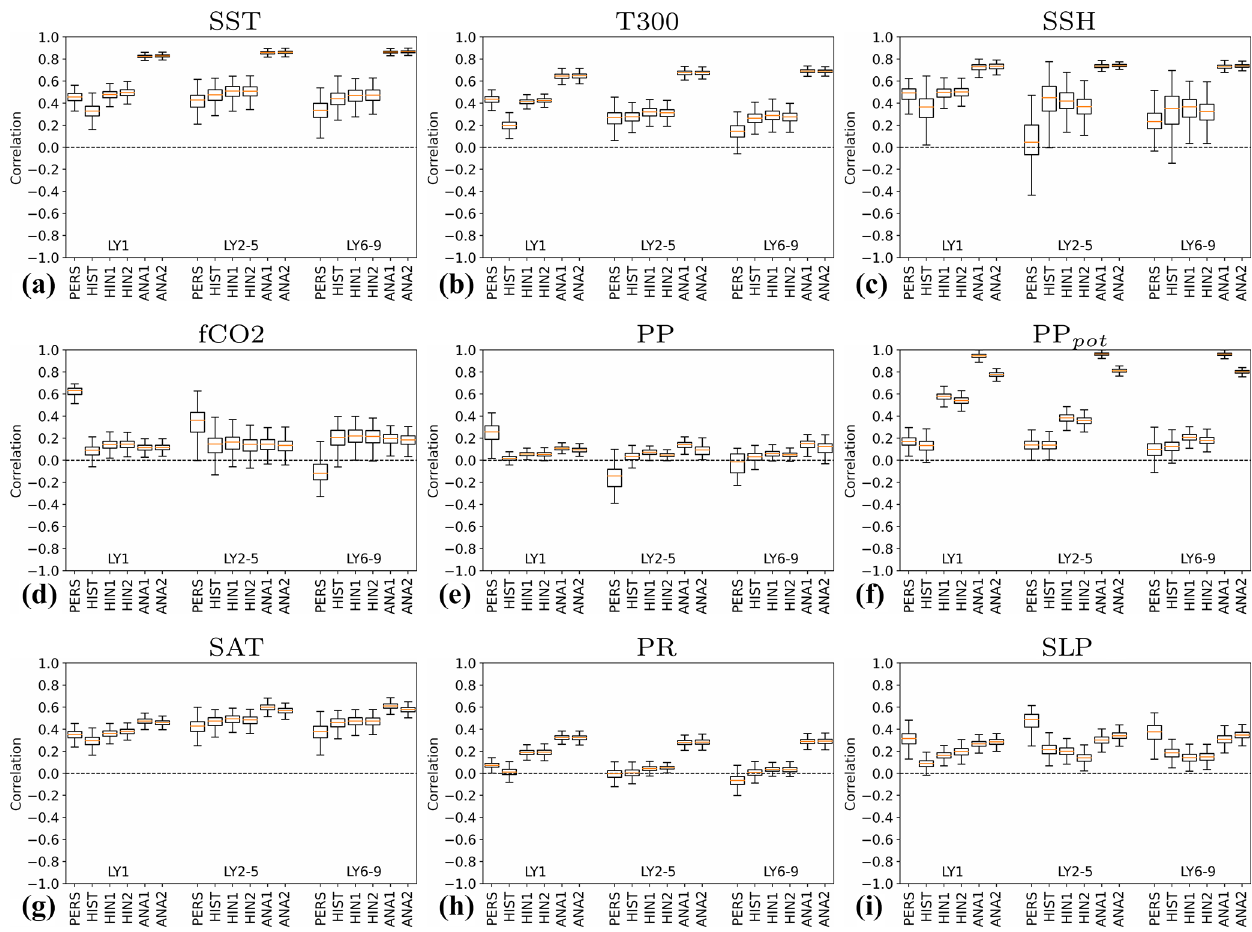
Figure 21. Global correlation skill for sea surface temperature (SST, a ), 0–300m temperature ( T 300, b ), sea surface height (SSH, c ), surface CO 2 flux ( f CO 2 , d ), column-integrated primary production (PP, e, f ), 2m air temperature (SAT, g ), land precipitation (PR, h ) and sea level pressure (SLP, i ). The ACCs are computed over time and space after weighting with the square root of the cell area. The box plots are constructed from 1000 bootstrap ACC realizations. Potential predictability ∗ of PP (f) is referenced to assim-i1